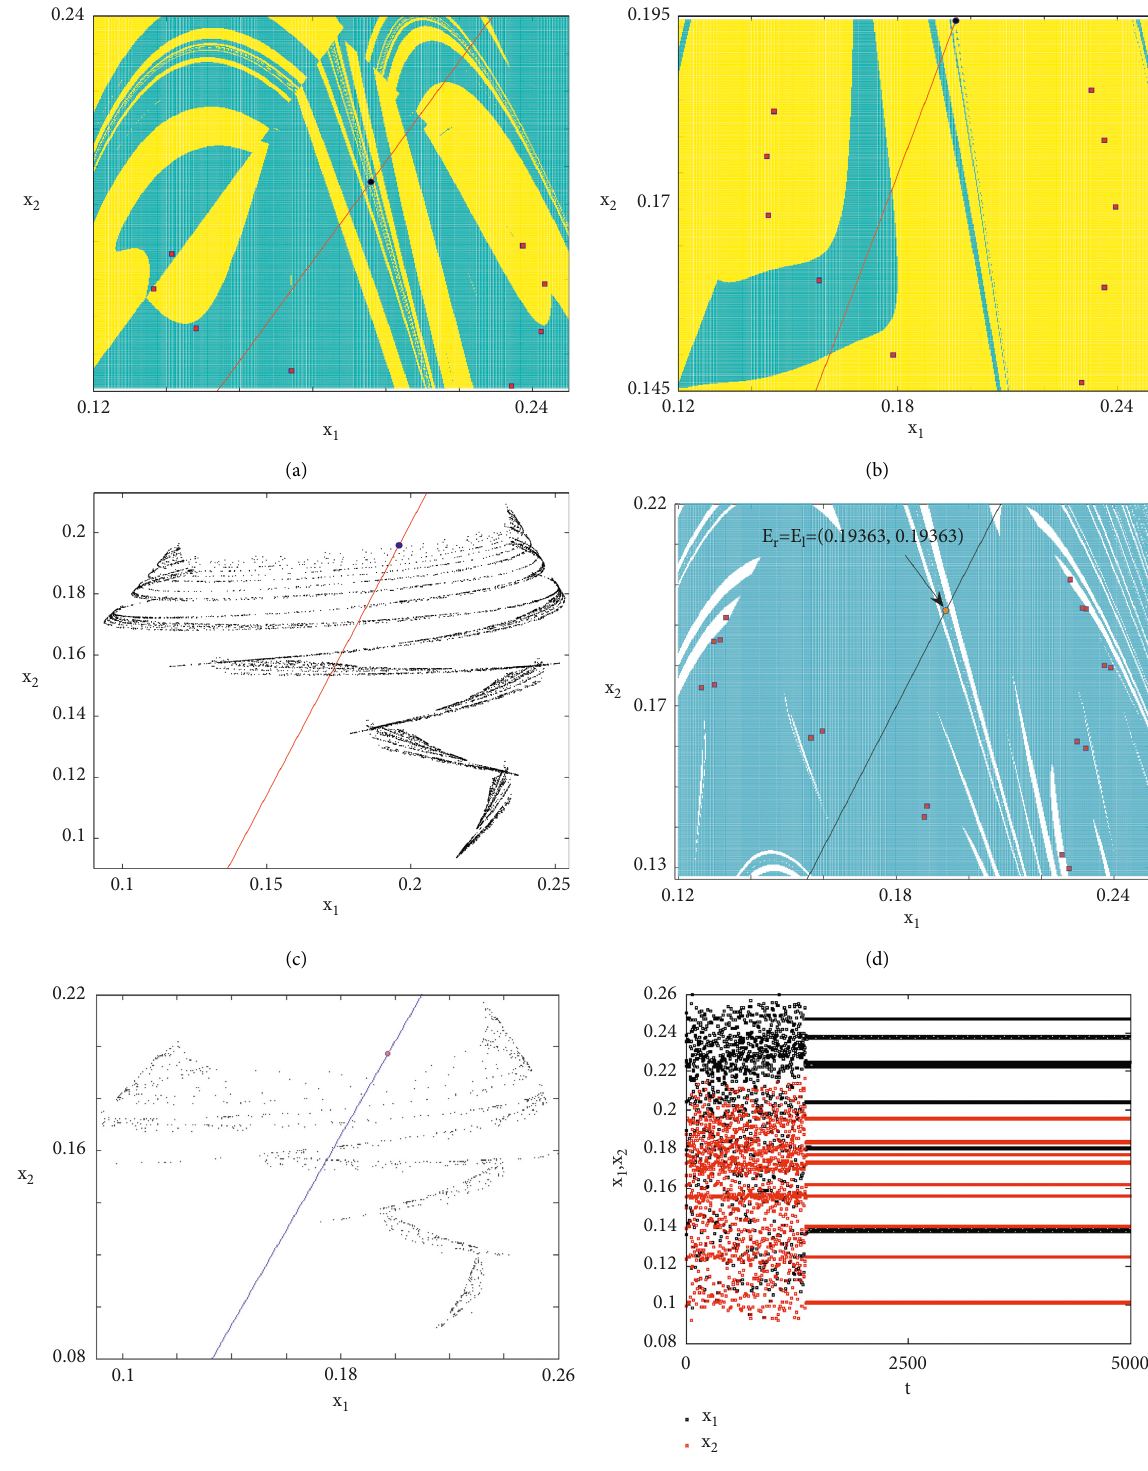
Figure 4: (a) Basin of attraction of the period 8-cycle. (b) Basin of attraction of the period 10-cycle. (c) Phase space of chaotic attractor. (d) Basin of attraction of the period 18-cycle. (e) Chaotic attractor that is changed into stable period 18-cycle. (f) Times series for the chaotic attractor given in Figure